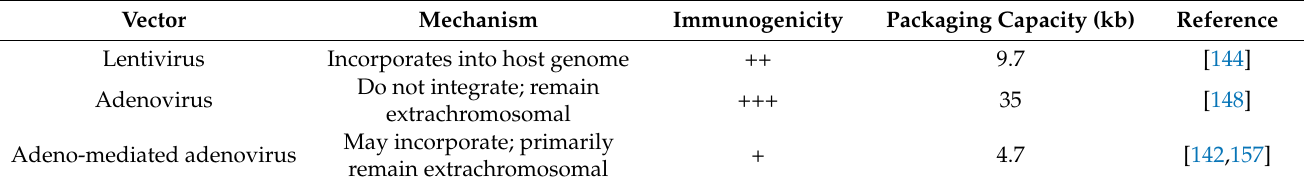
Table 3. Summary of the viral delivery methods for CRISPR/Cas9 (+: Low; ++: Moderate; +++: High) Vector Mechanism Immunogenicity Packaging Capacity (kb)